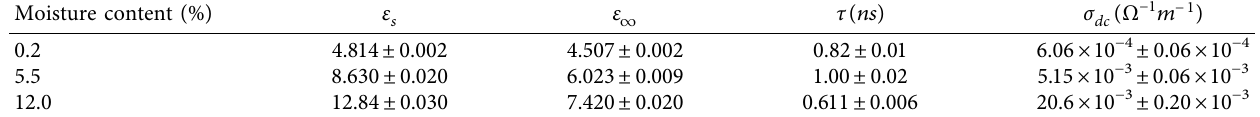
Table 2: Fitted parameters of the concrete with diferent moisture content [6].